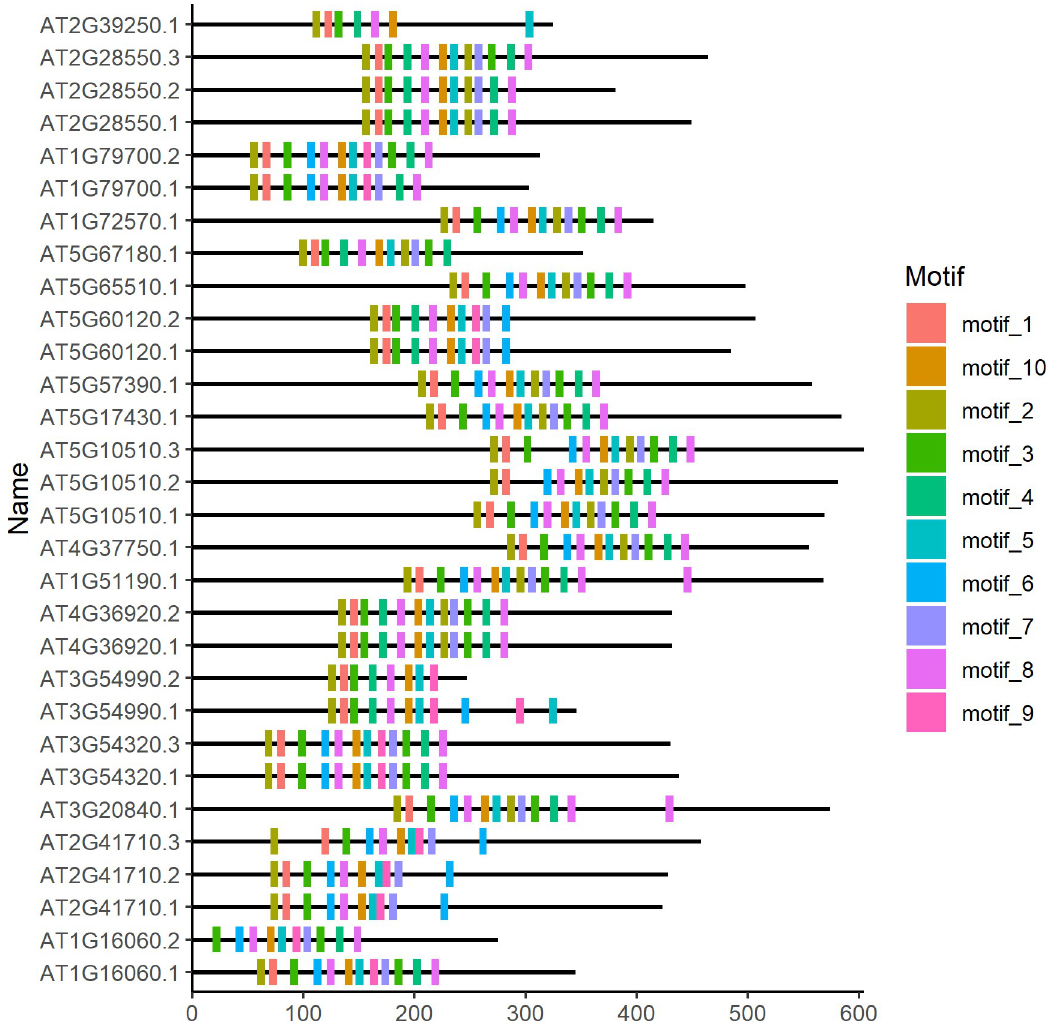
Fig 2. The location of motifs on the corresponding